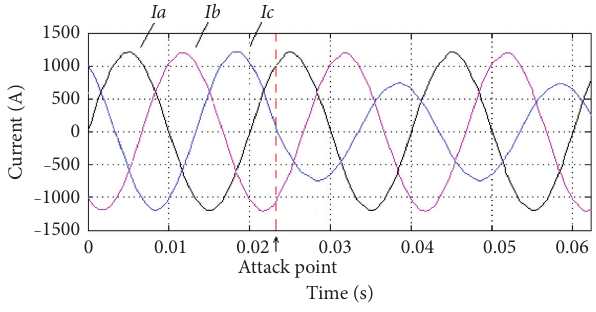
Figure 8: Three-phase current on the secondary side of the transformer before and after the A II u attack.